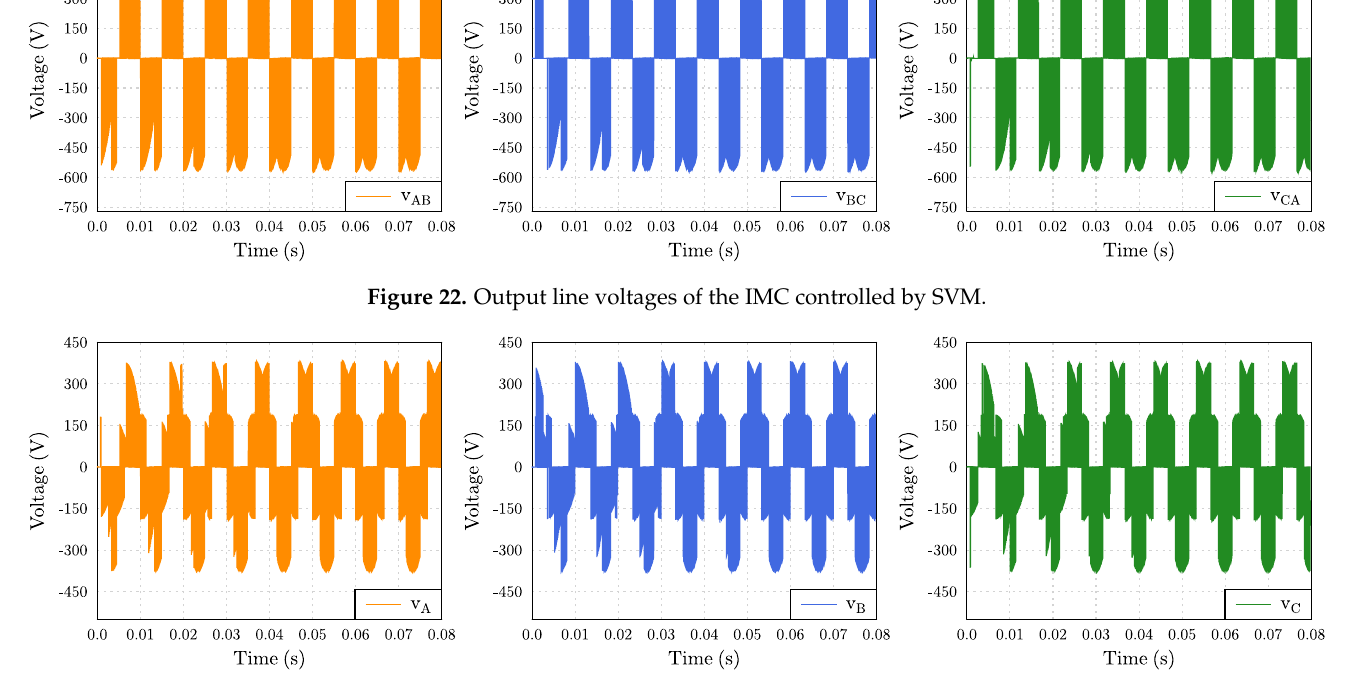
Figure 23. Output phase voltages of the IMC controlled by